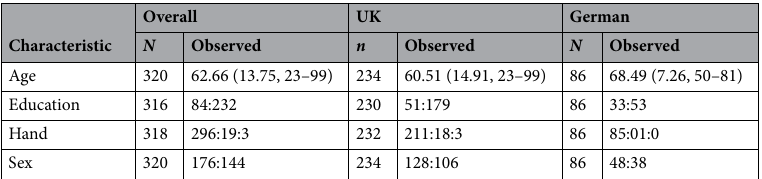
Table 1. Demographic characteristics of the normative sample and subdivided demographics for UK and German samples on OCS-Plus subtasks. Oxford Cognitive Screen-Plus (OCS-Plus). Age is formatted as follows: M (SD, range), education is formatted as follows: standard education/higher education. Hand refers to dominant hand of the participant throughout their life and is formatted as right:left:ambidextrous. Sex is binarised as male or female based on presentation of the individual at testing as coded as male:female. Some values are missing due to attrition over time (2014–2019), with some participants no longer available to be contacted for correct information. Standard education was differentially characterized for the German and UK samples due to variations in education scoring, whereby the German cohort were marked on school years, and the UK were marked on number of years in formal education including higher education. For this reason, we do not present education in years as the differences between German and UK samples would be misleading to the idea that the German sample were less educated. For the UK cohort on the basis of school running from 5–18, we classed standard education as ≤ 12 years and higher education as ≥ 13 years. For the German cohort having a university degree separated the standard or high education sample. No data were collected on